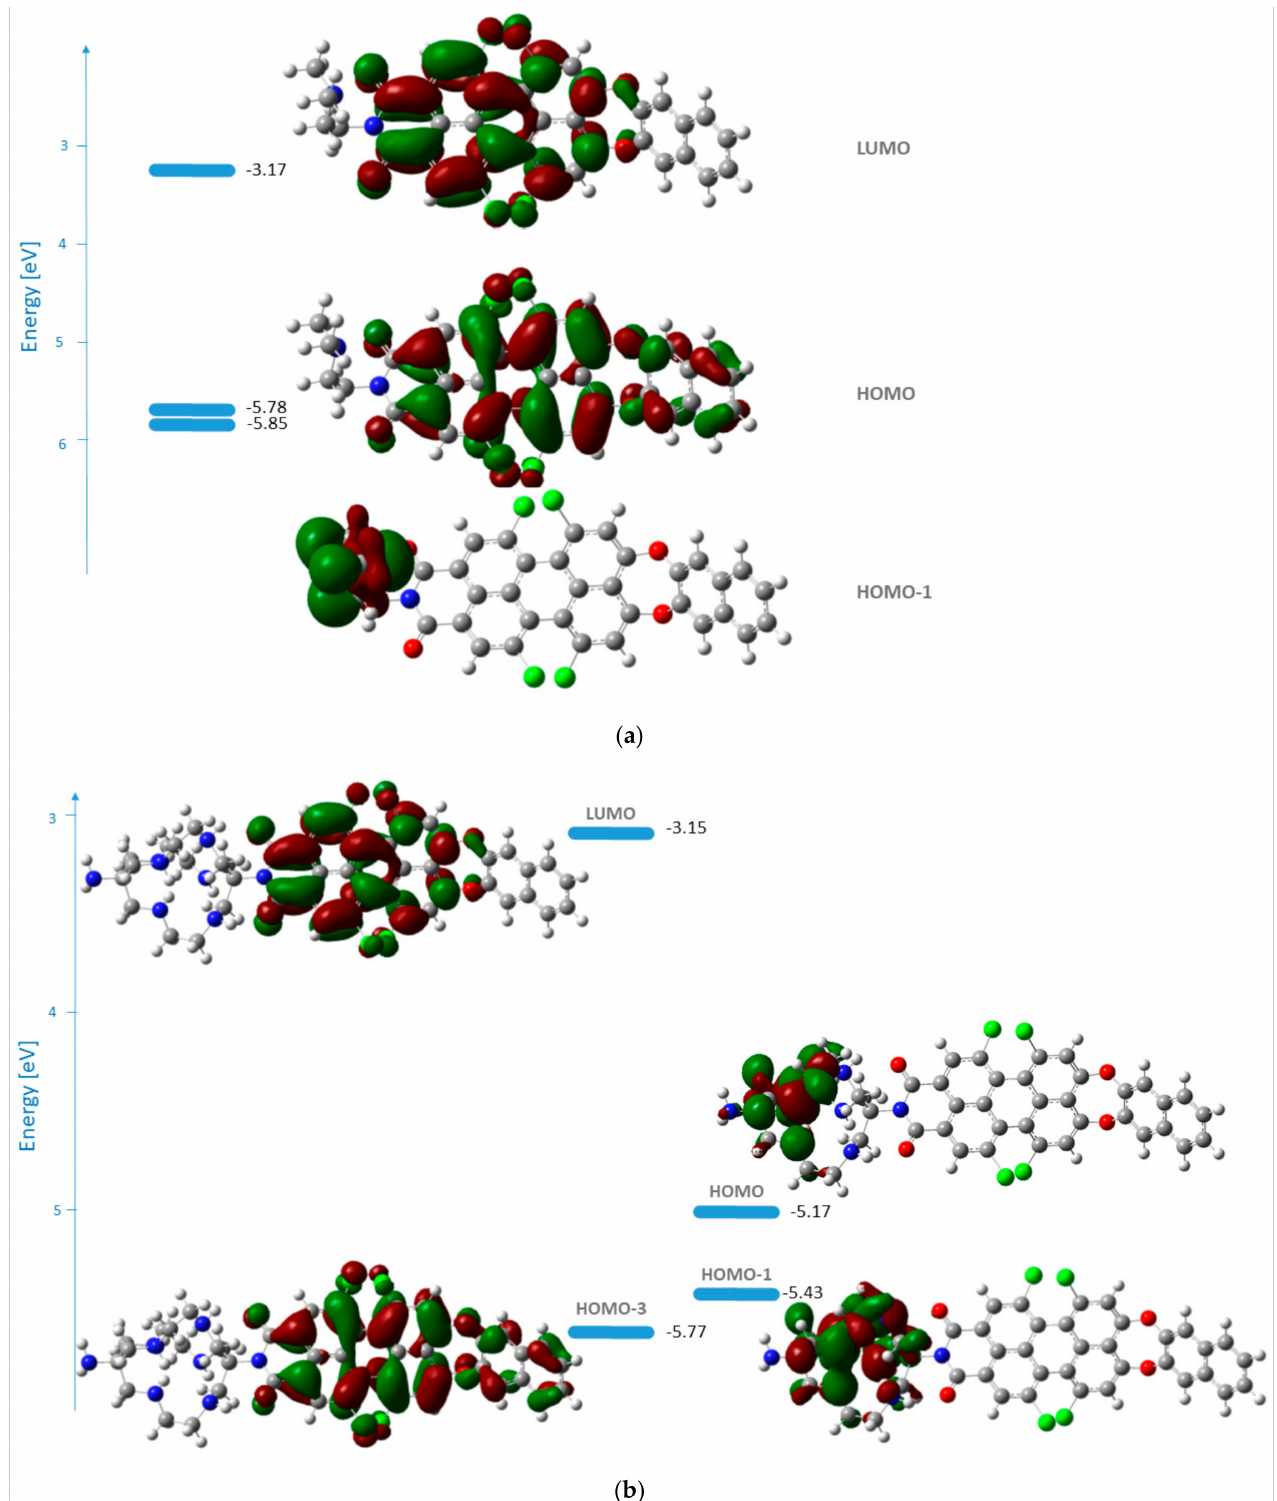
Figure 3. Energies and shape representations of the ground state orbitals in methanol from TDB3LYP/6-31G(d,p) computations: ( a ) HOMO − 1, HOMO, and LUMO of 1b ; ( b ) HOMO − 3, HOMO − 1, HOMO, and LUMO of 1c